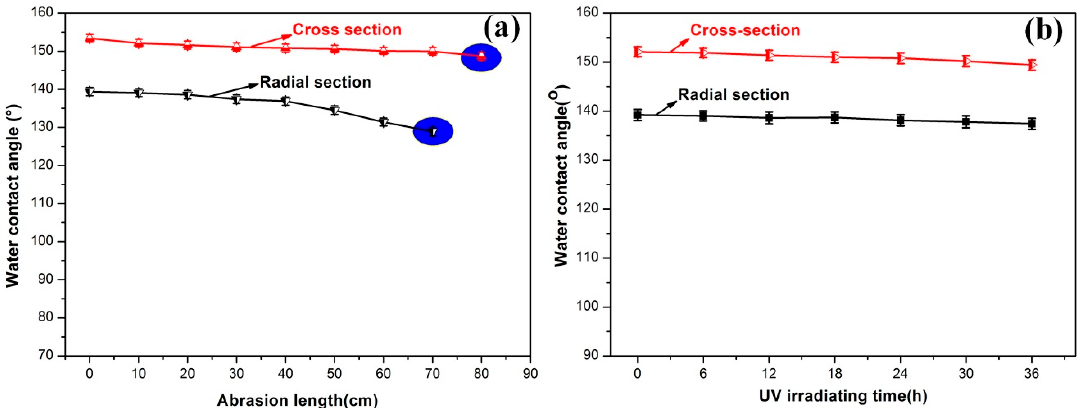
Figure 6. ( a ) WCA variations as a function of the abrasion length; ( b ) the change in WCA of treated wood as a function of UV irradiation time.